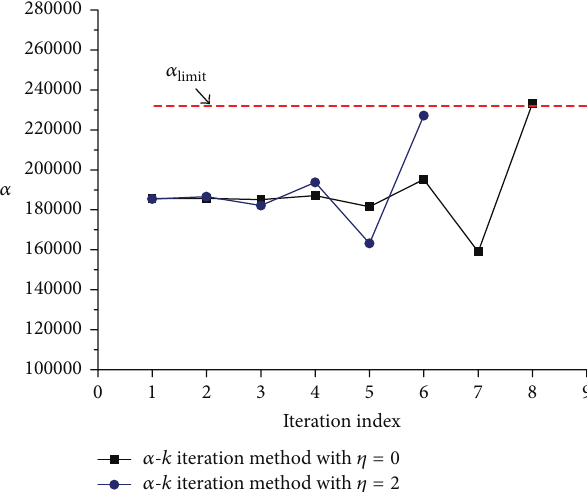
Figure 1: Iteration-wise 𝛼 values estimated by the 𝛼 -k iteration method for the two-group infinite homogeneous problem of 𝑘 𝑝 =